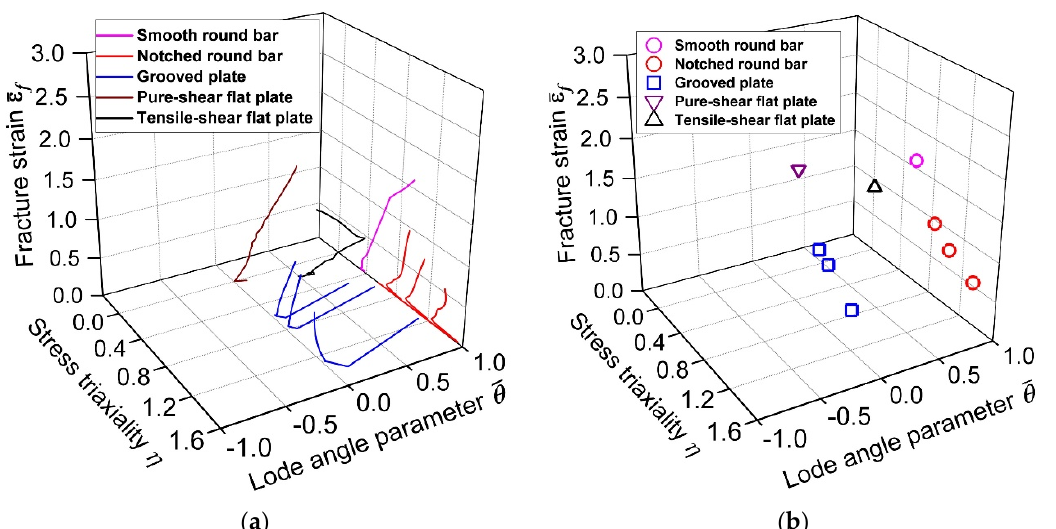
Figure 3. ( a ) Stress triaxiality and Lode angle parameter variation history obtained from each Q460 steel test specimen; ( b ) fracture strain obtained from each Q460 steel test specimen (average values of the stress triaxiality and Lode angle parameter were used to determine the fracture strain) [33]. According to Table 2 and Table 3, the hardening exponent n and uniaxial tensile fracture strain ε f 0 of the Q460 steel can be directly determined through the test result of the smooth round bar specimen, i.e., n = 0.2, ε f 0 = 1.599. Then, the fracture strain of the Q460 steel under different stress states can be directly determined through Equation (22). Figure 4a shows the fracture envelope (i.e., the fracture strain surface in terms of the stress triaxiality and Lode angle parameter) of the investigated Q460 steel predicted from the calibrated new fracture model, where the difference between the test data points and fracture envelope is represented by the corresponding vertical error bar. Further, to better distinguish the ductility limit of the material under each stress state, two-dimensional fracture strain locus under generalized tension ( θ = 1), generalized compression ( θ = − 1), pure-shear and plane strain tension ( θ = 0) are also shown in the figure. As shown in Figure 4a, different stress states. The fracture strain data points obtained from each notch